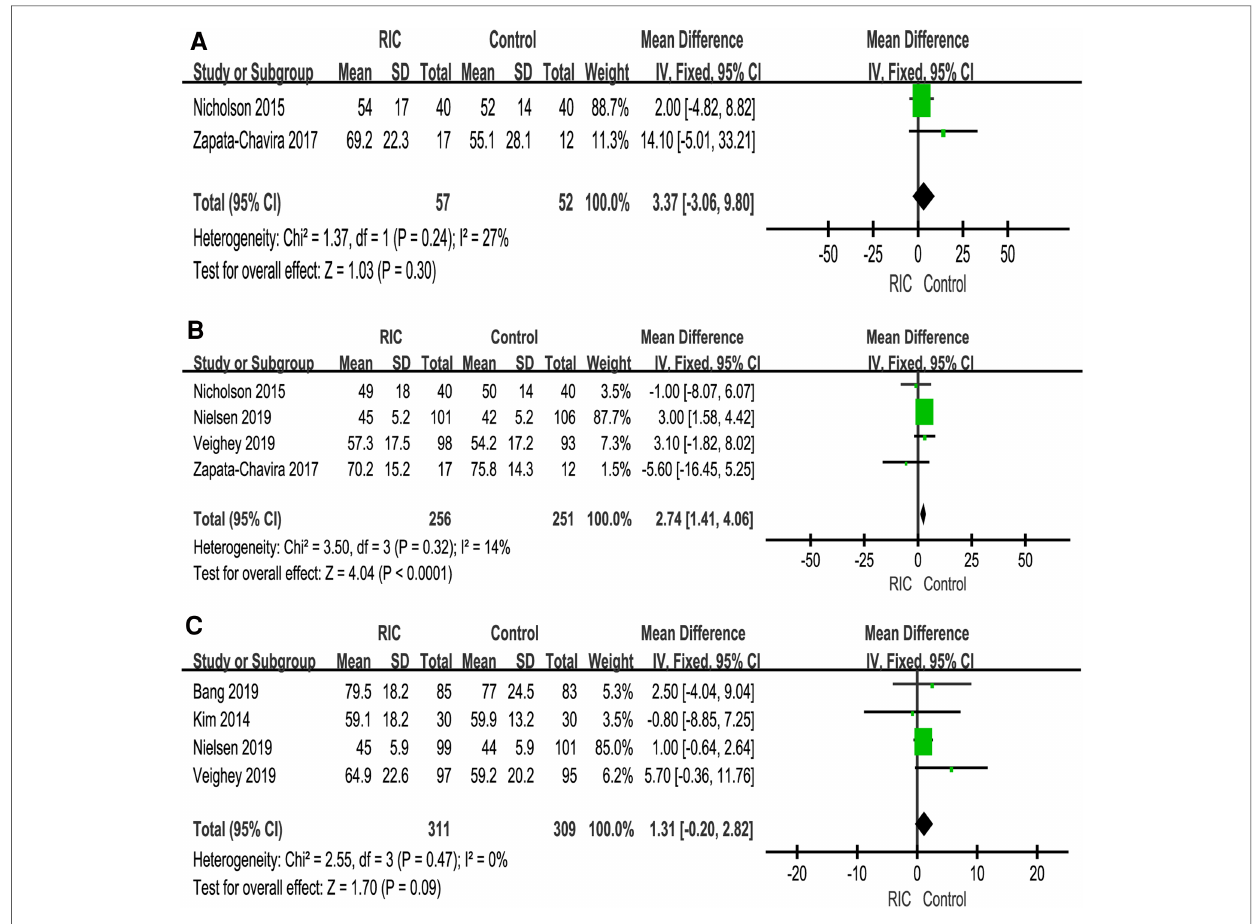
FIGURE 3 Forest plot with 95% con fi dence intervals for continuous primary end points. The eGFR at 1 month postoperation ( A ); eGFR at 3 months postoperation ( B ); eGFR at 12 months postoperation ( C ). RIC, remote ischemic conditioning; eGFR, estimated glomerular fi ltration